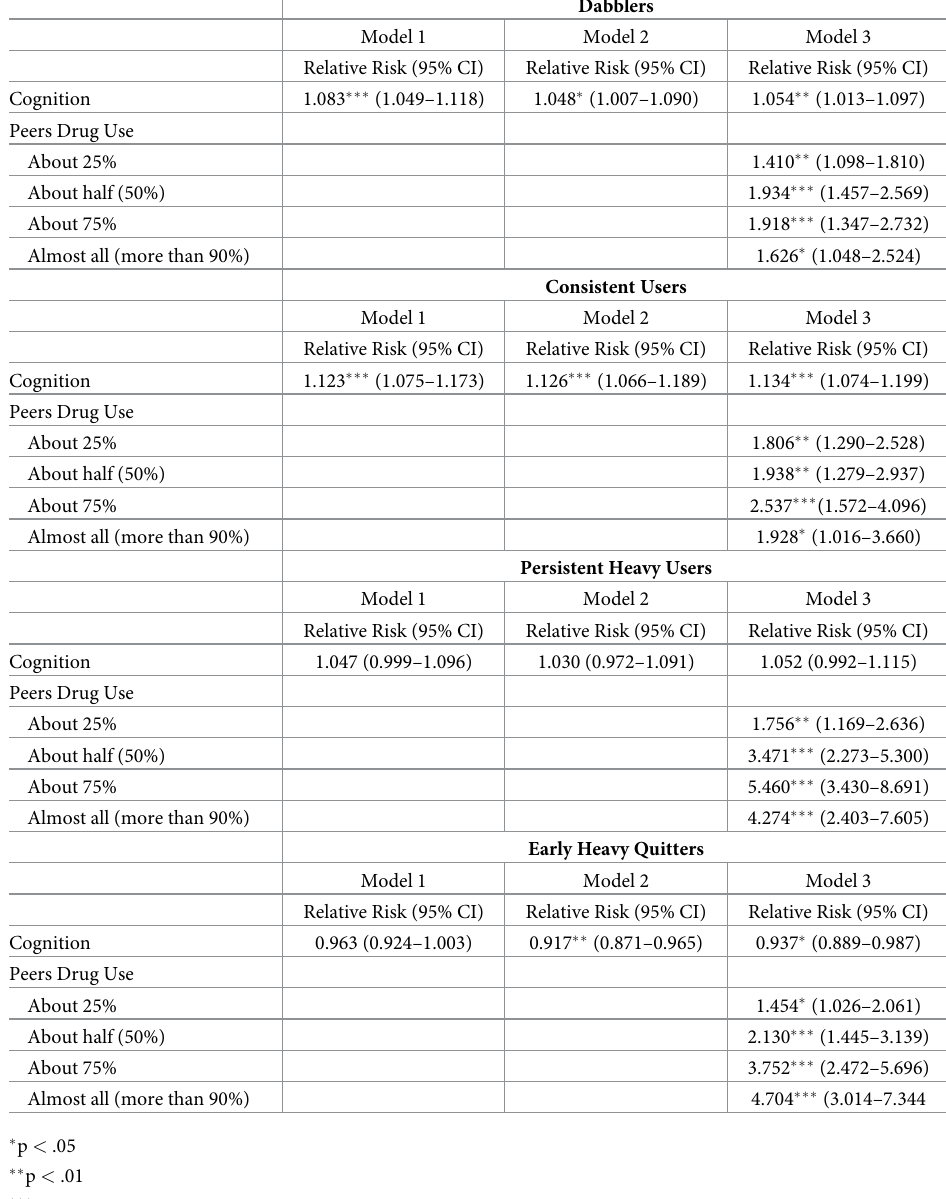
Table 3. Multinomial logistic regression of cognitive aptitude and heterogeneous trajectories of marijuana use from age 16 through age 26 (n =